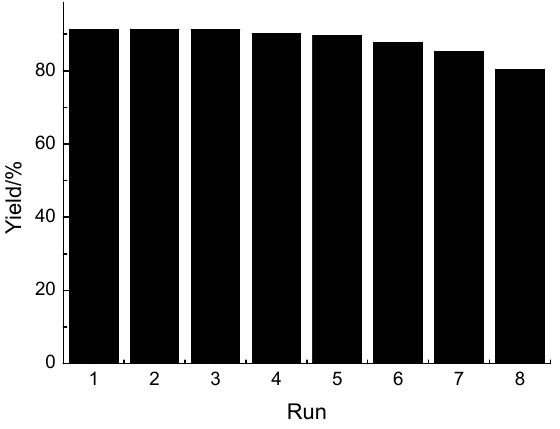
Figure 3. Reusability of the GBAIL-C benzaldehyde, 1.0 mmol aniline, 1.0 mmol cyclohexanone, 0.050 mmol catalyst, 1.5 mL H 5 h, 25 °C.